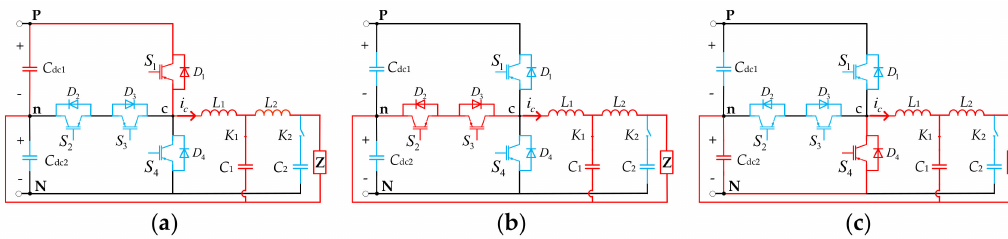
Figure 3. AC mode T-type three-level converter current loop. ( a ) + 1 level; ( b ) − 1 level; ( c ) 0 level.